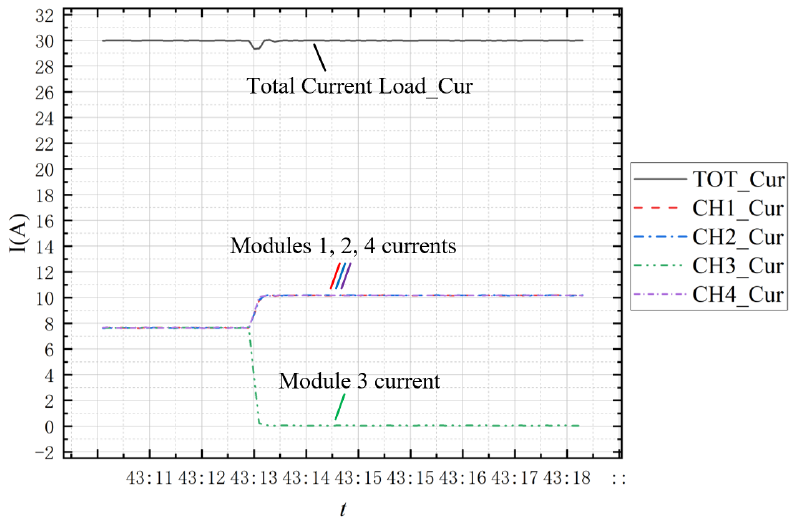
Figure 22. Current change after module 3 failure in the current sharing